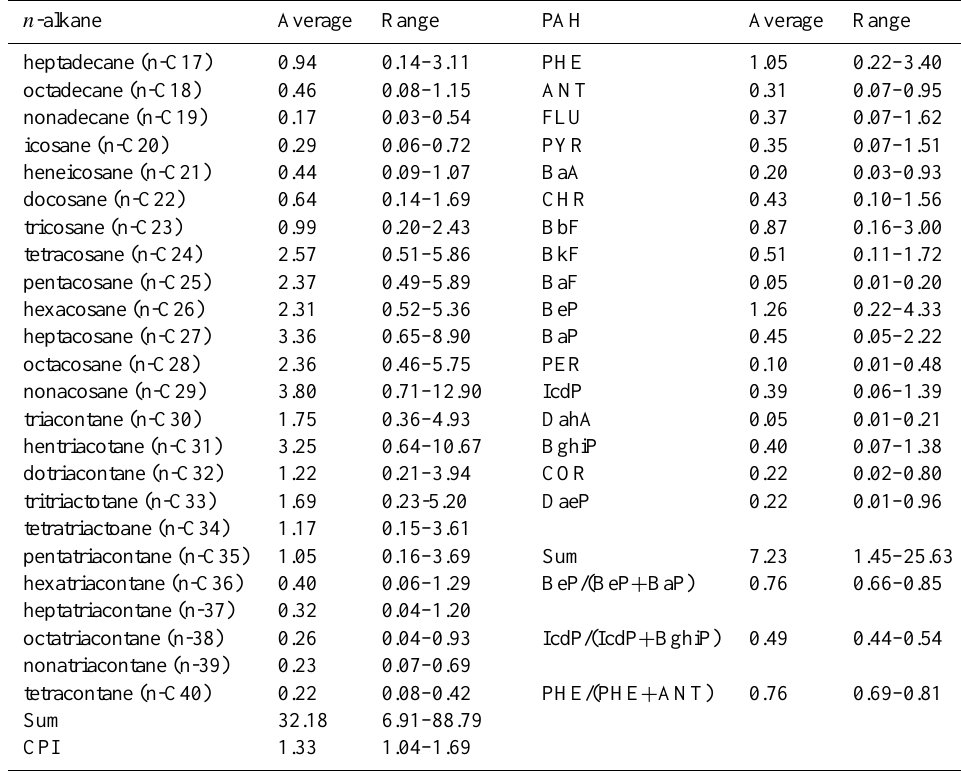
Table 4. Concentrations (units: ngm − 3 ) and some indices of n -alkanes and PAHs. n -alkane